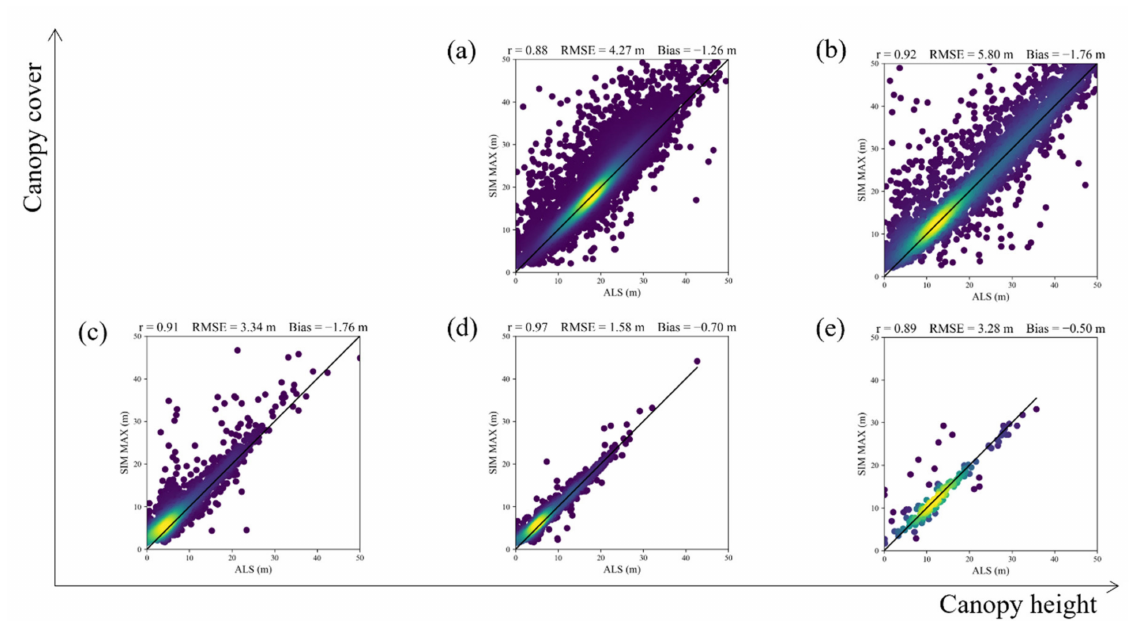
Figure 5. RH95 from the simulator’s Maximum algorithm compared to ALS benchmark heights, for eucalypt forests with canopy height/cover: ( a ) Medium/Open, ( b ) Tall/Open, ( c ) Low/Woodland, ( d ) Medium/Woodland, ( e )